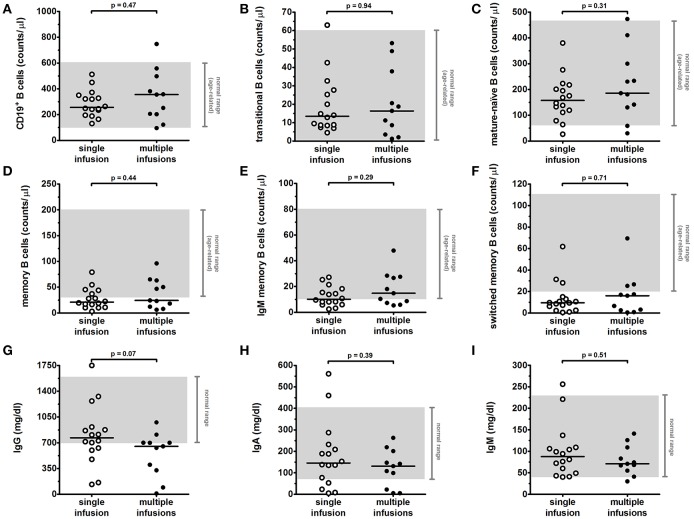
Long-term effects of single vs. multiple anti-CD20 infusions on levels of circulating B-cell subsets and total serum immunoglobulins in children with INS. Levels of B-cell subsets (A–F) and of immunoglobulins (G–I) were analyzed in INS pediatric patients as described in Figure 1 at last-follow-up following anti-CD20 treatment. Patients who received a single infusion (n = 16) were compared to patients who received multiple (≥2) infusions (n = 11) of anti-CD20. Each plot represents a different patient after single (with) or multiple (black) infusions. Gray areas represent the age-related normal range between the 5th and 95th percentiles indicated in Piatosa et al. (15) for the different B-cell subsets and by the diagnostic laboratory of our Institution for immunoglobulins. Differences between groups were compared using the non-parametric unpaired Mann-Whitney U test.